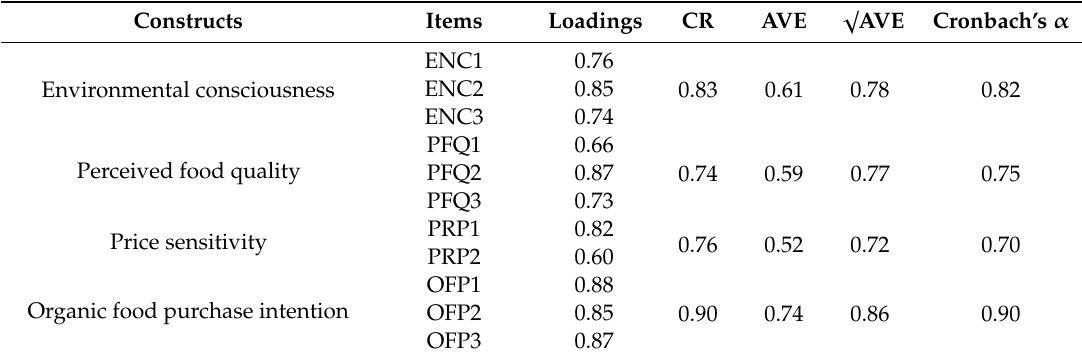
Table 4. Confirmatory factor analysis